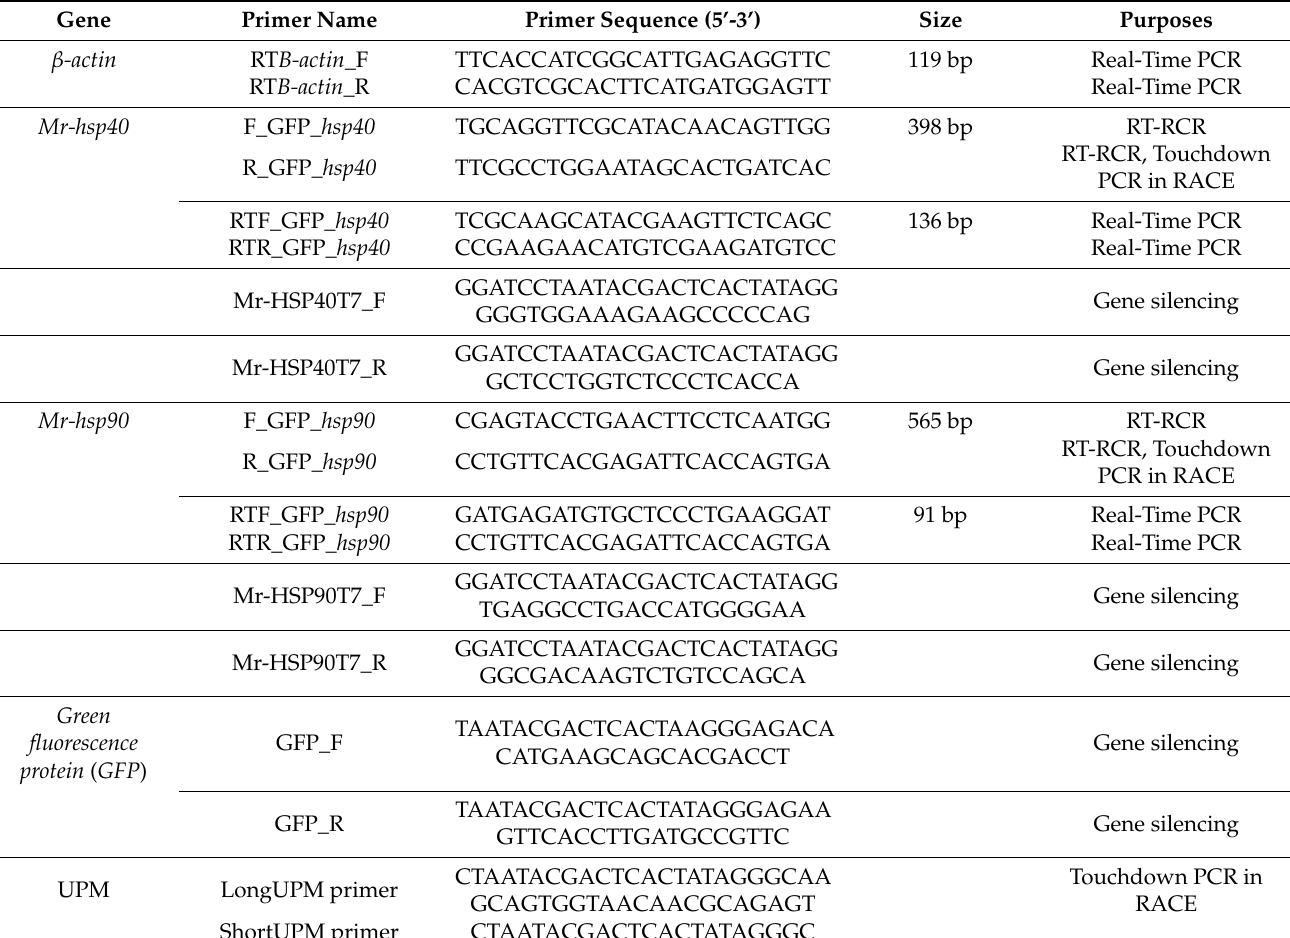
Table 1. PCR primers and primer sequences used for the amplification of hsp40 , hsp90 and β -actin gene